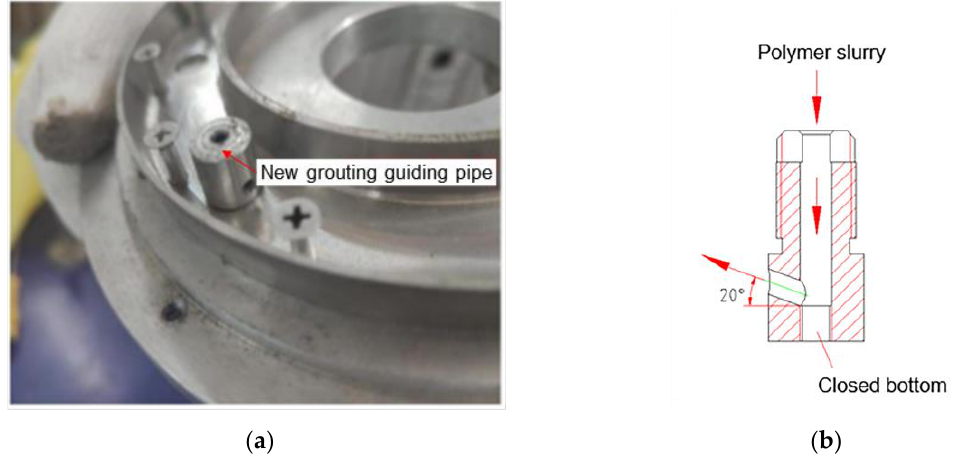
Figure 4. Original design grouting guiding pipe: ( a ) grouting guiding pipe; ( b ) grouting guiding pipe profile.